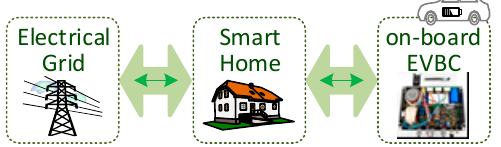
Figure 7. On-board EVBC: vehicle-to-grid (V2G) operation mode.